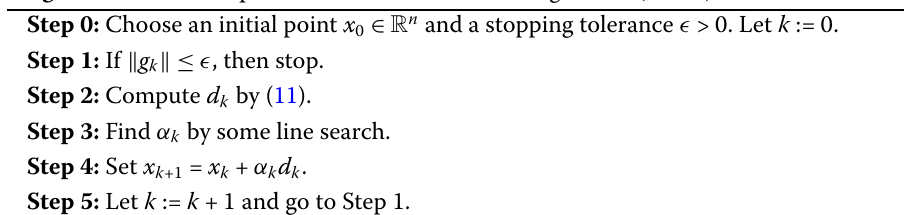
Algorithm 1: Least-squares-based three-term CG algorithm